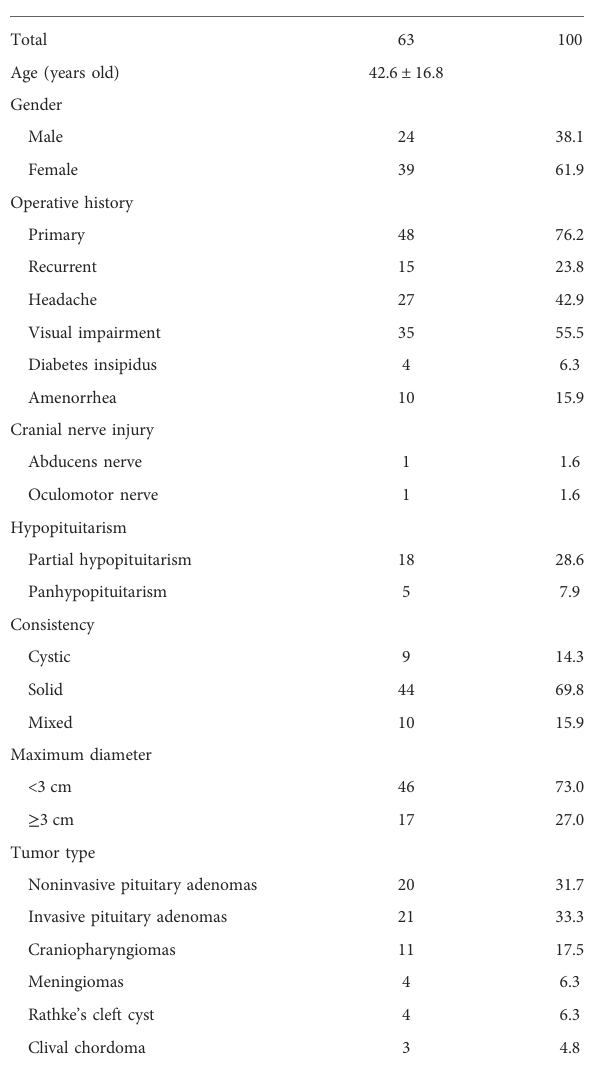
TABLE 1 Clinical manifestation and characteristics of patients before